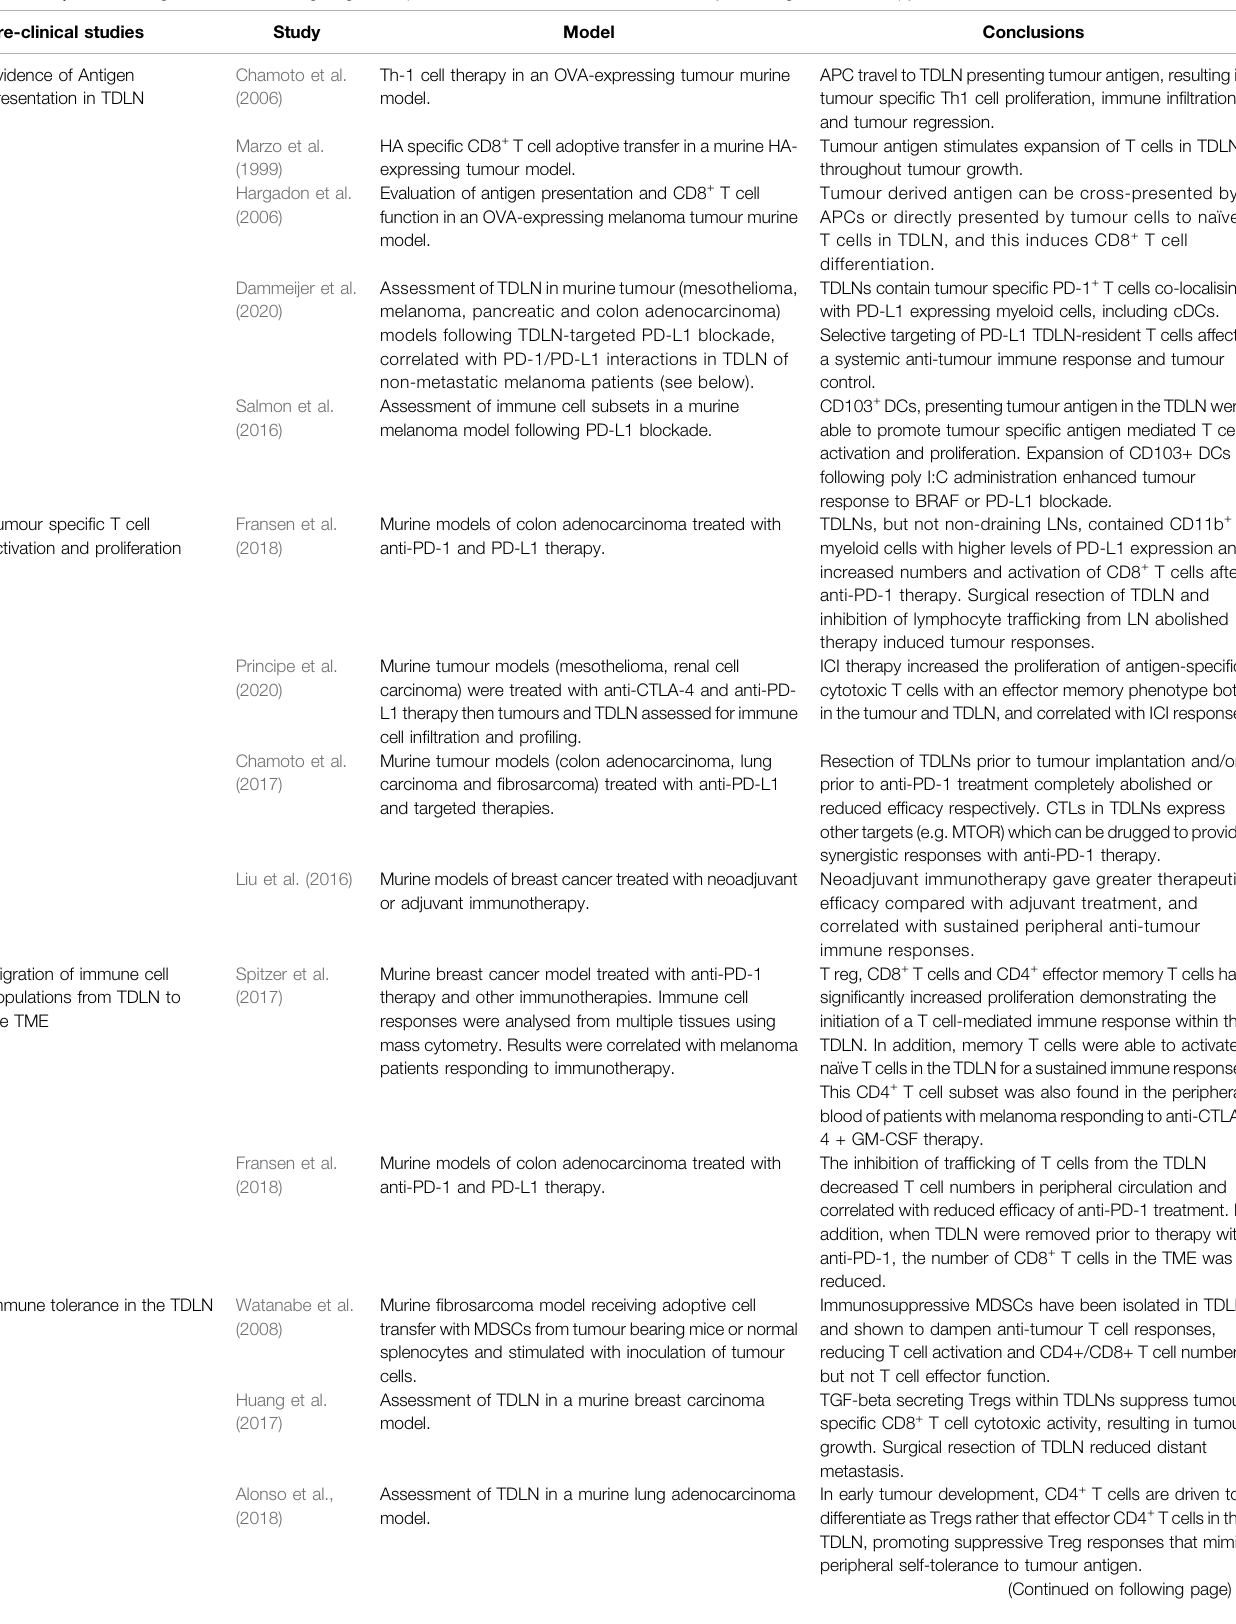
TABLE 1 | Summarising the studies investigating the importance of TDLN in anti-tumour immunity following immunotherapy. Pre-clinical